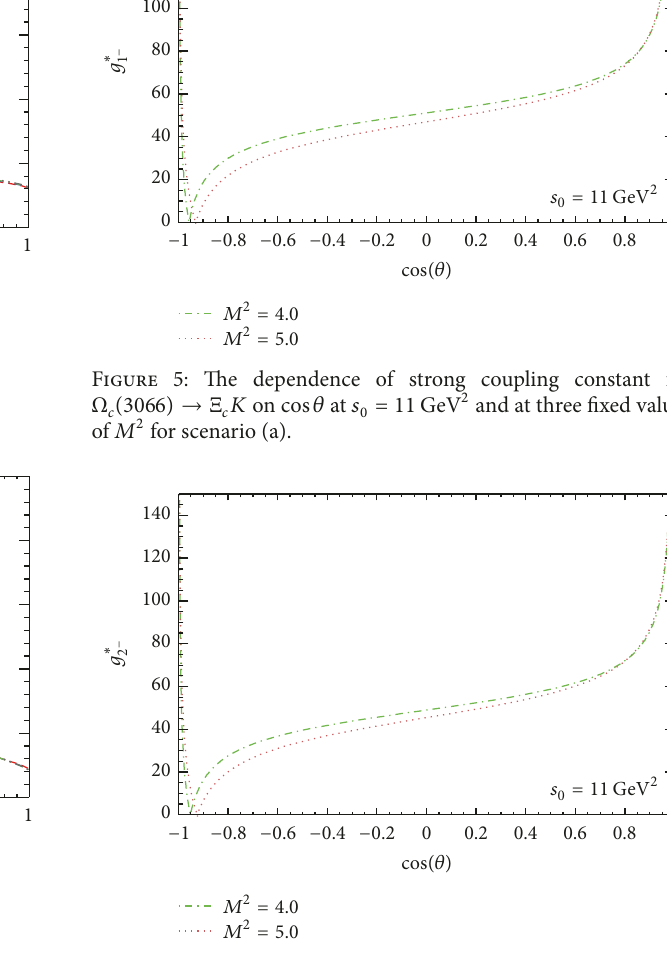
Figure 6: Same as in Figure 5, but for Ω 𝑐 (3090) → Ξ 𝑐 𝐾 transition.